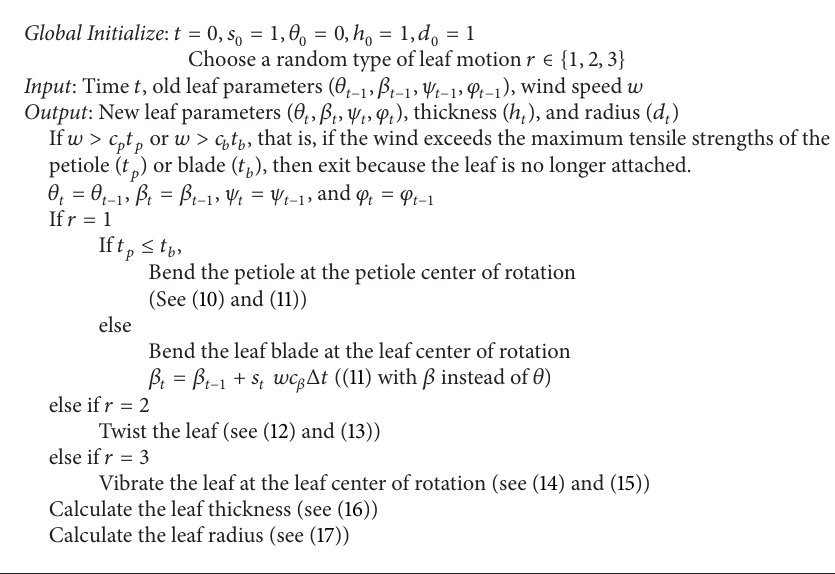
Algorithm 2: The general algorithm for growth and movement of one leaf.